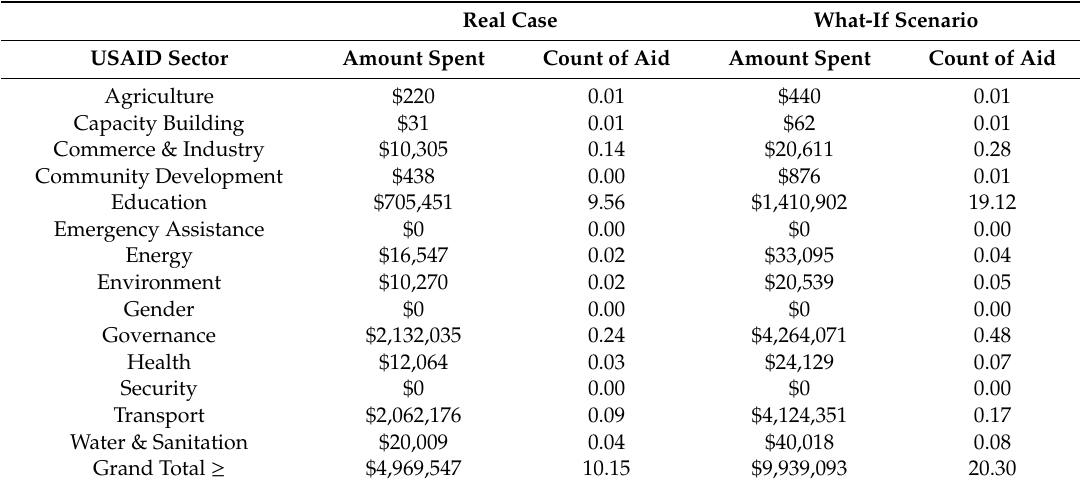
Table 5. USAID distribution for the real case and what-if scenario for